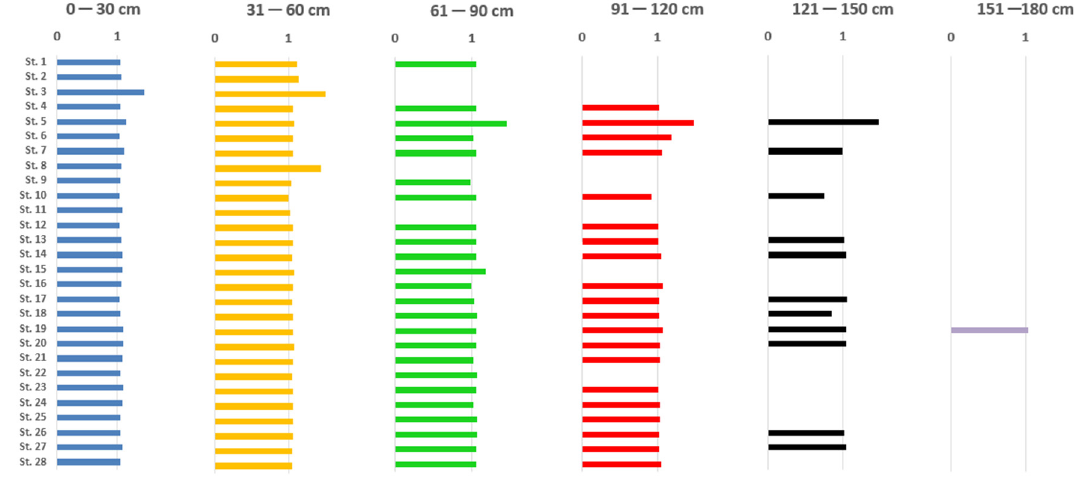
Figure 7. Mean density of the bottom sediment of Karczemne Lake (g cm − 3 ).